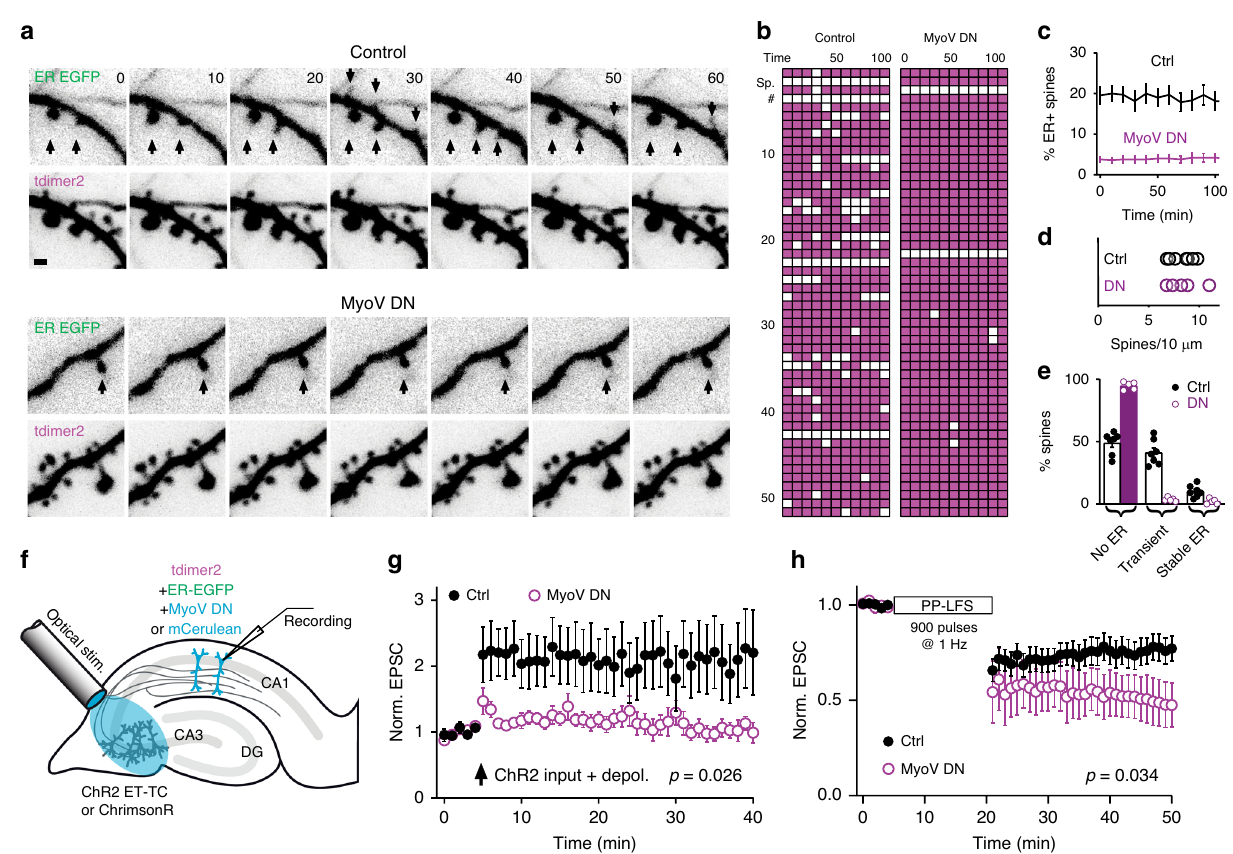
Fig. 3 ER motility is driven by myosin V. a Time-lapse imaging of ER motility in dendritic sections of CA1 pyramidal cells expressing just the fl uorescent markers (control) or, in addition, the dominant-negative construct MyoV DN. Scale bar: 1 µ m. b Spine ER score charts of a MyoVa DN-expressing neuron and control (ER + spines: white; ER − spines: magenta). Note persistent ER in two spines of the MyoVa DN neuron. c Percentage of spines containing ER over time in control ( n = 896 spines, 7 slices, 7 neurons) and MyoV DN-expressing CA1 neurons ( n = 567 spines, 5 slices, 5 neurons). Data are mean ± SEM. d Spine densities on dendrites of control (seven slices, seven neurons) and MyoV DN neurons ( fi ve slices, fi ve neurons) (8.3 ± 0.4 vs 8.4 ± 0.7 spines per 10 µ m, p = 0.8835, two-sided unpaired t -test). Points show mean ±SEM. e MyoV DN signi fi cantly increased the number of spines that were never visited by ER (49±3% vs 95±1%, p < 0.0001, unpaired t -test), decreased the number of transient ER visits (41± 4% vs 4 ±1%, p < 0.0001, two-sided unpaired t -test) and the number of spines containing stable ER (10± 2% vs 2 ±1%, p = 0.0052, two-sided unpaired t -test) over a 100min imaging period. Markers represent individual neurons ( n = 7 neurons for control, n = 5 neurons for MyoV DN), bars show mean ±SEM. f Pairing optogenetic stimulation of CA3 pyramidal cells with step depolarization of a patch-clamped CA1 pyramidal cell expressing fl uorescent proteins and MyoV DN or just fl uorescent proteins (control). g Pairing optogenetic stimulation with 100ms postsynaptic depolarization to − 15 mV (ten repeats) induced LTP in control CA1 pyramidal cells, but not in neurons expressing MyoV DN instead of mCerulean (ctrl = 221% ±55% of baseline, n = 10 neurons, 10 slices; MyoV DN = 97%±11% of baseline, n = 12 neurons, 12 slices; p = 0.026, two-sided unpaired t -test). Datapoints are mean± SEM. h Low-frequency stimulation (900 repeats, 1Hz, paired pulses) induces stronger LTD in neurons expressing MyoV DN (ctrl: 77%± 7% of baseline, n = 12 neurons, 12 slices; MyoV DN: 47%±12% of baseline, n = 5 neurons, 5 slices; p = 0.033, two-sided unpaired t -test). Datapoints are mean± SEM; source data are provided as a Source Data fi